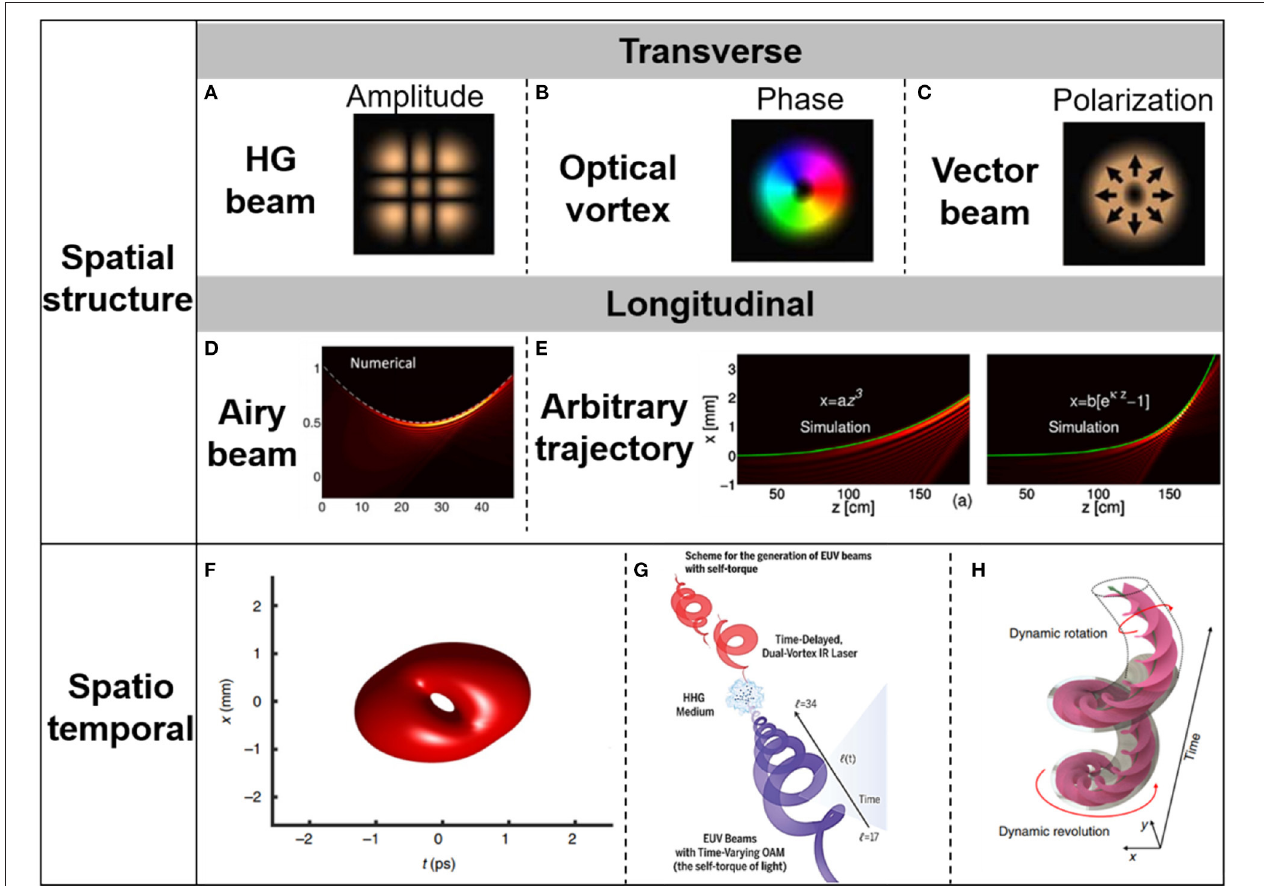
FIGURE 1 | Introduction of different types of structured light beams. (A–C) Structured light with transverse amplitude inhomogeneities, phase inhomogeneities, and polarization inhomogeneities. (D) An Airy beam with a parabolic trajectory. Reprinted from Froehly et al. [11]. (E) Longitudinal structured light with arbitrary trajectories. Reprinted from Greenfield et al. [12]. (F–H) Spatiotemporal structured light. Reprinted from Chong et al. [13], Rego et al. [14], and Zhao et al.